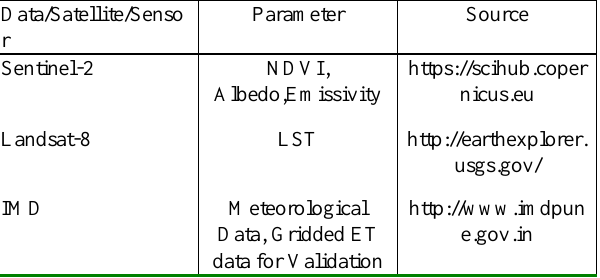
Table 1. Summary of setellites and Source